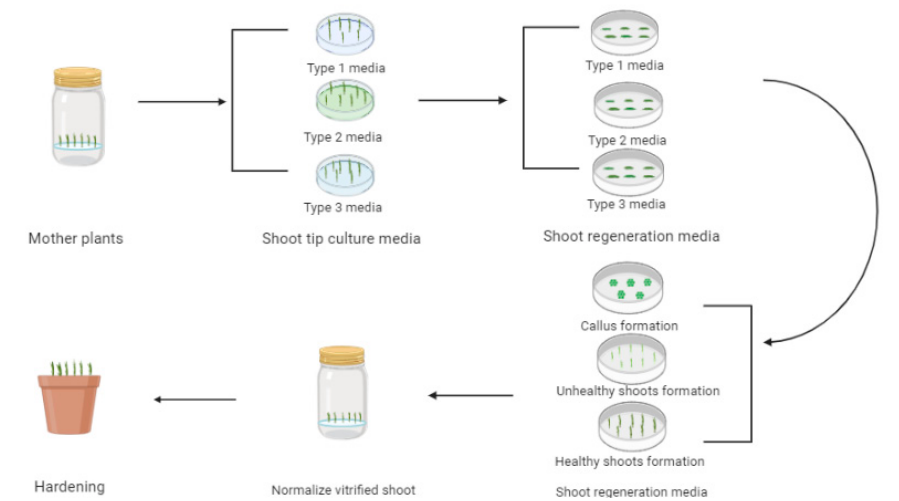
Figure 3. Flow chart showing efficacy of shoot regeneration from different types of leaves in the carnation cultivars.